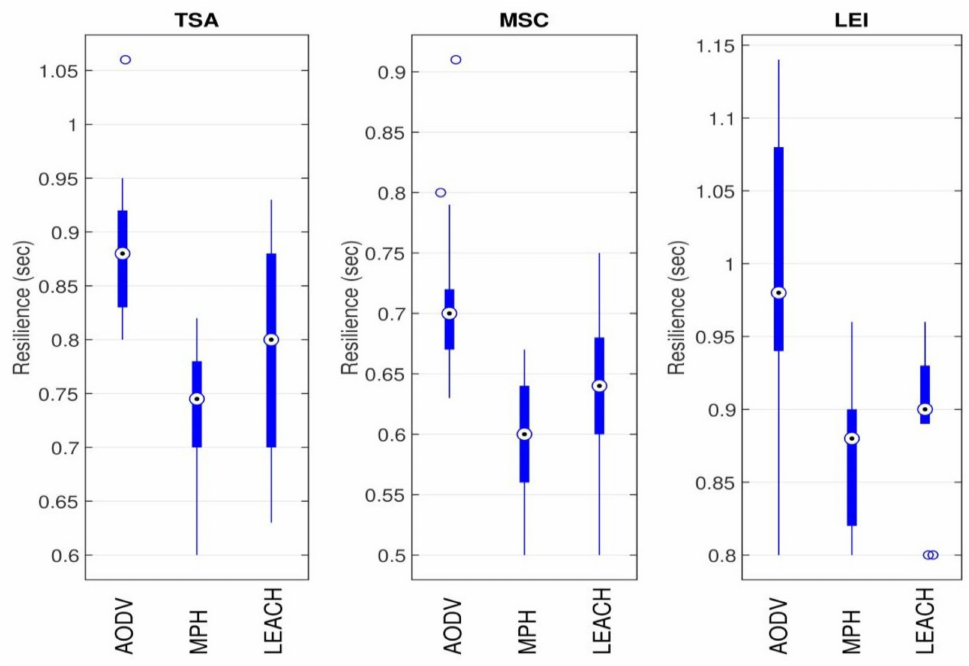
Figure 17. Resilience for the studied sleeping techniques and protocols under WiFi